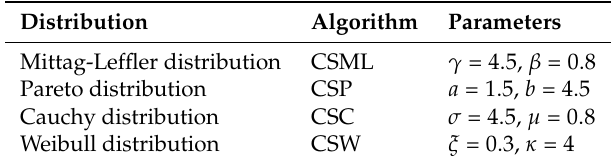
Table 1. Parameters for randomness-enhanced cuckoo search (CS)